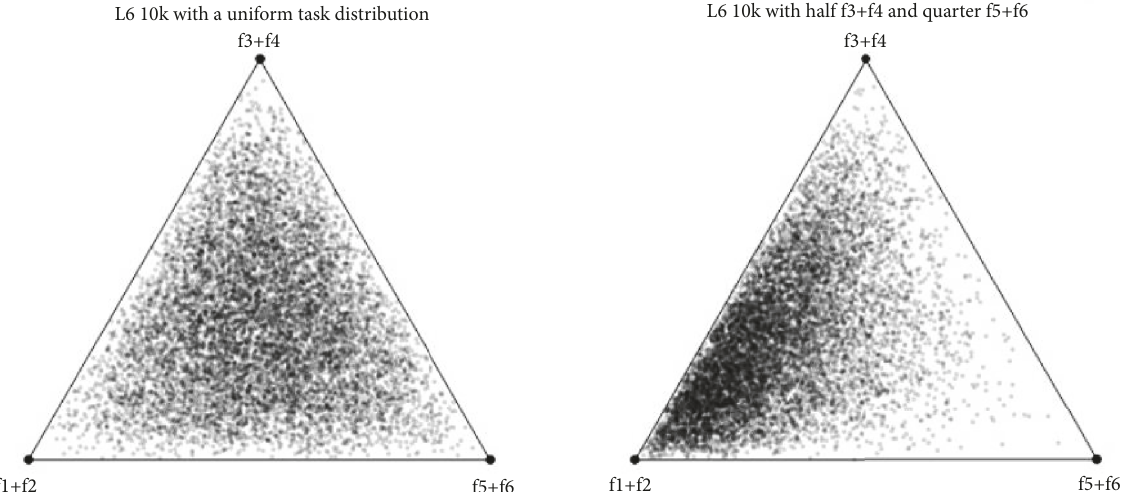
f1+f2 Figure 2: At left is a random simplex-point picked 6-layer population of 10,000 individuals, projected onto a ternary plot with subsystem correlations,forexample,in/outfromskininthelowerleft,in/outfromfamilyattop,andin/outfromcultureatlowerright,resultingin 𝑀 ∼ 4.26. At right is a similar 6-layer population, in which participation buffering of correlations that look in/out from family has 6 and 𝑀 geom been cut in half and of correlations that look in/out from culture has been divided by 4, resulting in 𝑀 might be expected, for example, for a human population that has limited access to jobs and even more-limited access to cultural/professional